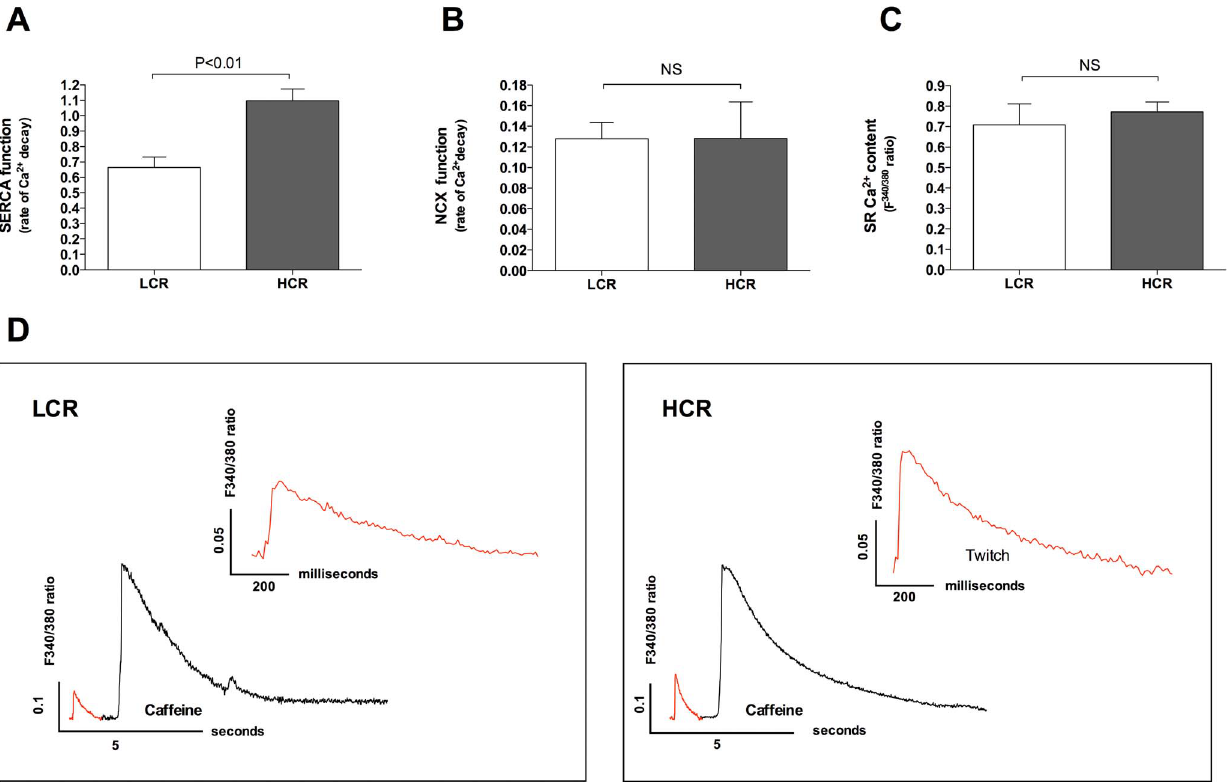
Figure 4. Measurements of sarcoplasmic reticulum (SR) and sarcolemmal Ca 2 + -handling properties. Total SR Ca 2 + content was measured by assessing peak Ca 2 + amplitude after rapidly applying Caffeine (10 mM) to the perfusion solution immediately after stopping the electrical stimulation in normal HEPES solution. To quantify the SERCA2a function, a simple model was used based on the following assumptions: SERCA2a transport rate is: K twitch – K Caffeine/NCX , where K twitch is the Ca 2 + removal (F 340/380 ratio) during the time period from peak electrical stimulated twitch Ca 2 + to 50% Ca 2 + decay in normal HEPES solution and the K Caffeine/NCX is the Ca 2 + removal (F 340/380 ratio) during the time period from peak caffeine induced Ca 2 + release to 50% of decay (10 mM Caffeine + HEPES). In presence of caffeine the SERCA is inhibited and the Ca 2 + removal in this condition is mainly determined by NCX. A, SR Ca 2 + ATPase (SERCA2a) function was significantly lower in Low Capacity (LCR) rats than High Capacity Runner (HCR) rats. B, Na + /Ca 2 + exchanger (NCX) function was not different between groups. C, SR Ca 2 + -content assessed by application of 10 mM of caffeine after electrical 1 Hz stimulation did not reveal any difference LCR and HCR atrial myocytes. n=5 animals, n=4 2 6 cells from each animal. Data are presented as mean 6 SD. D, Exemplary recordings of twitch Ca 2 + transients (red lines) compared to Caffeine transients (black lines). Twitch Ca 2 + transients are magnified in respective figures for better evaluation of Ca 2 + handling kinetics.